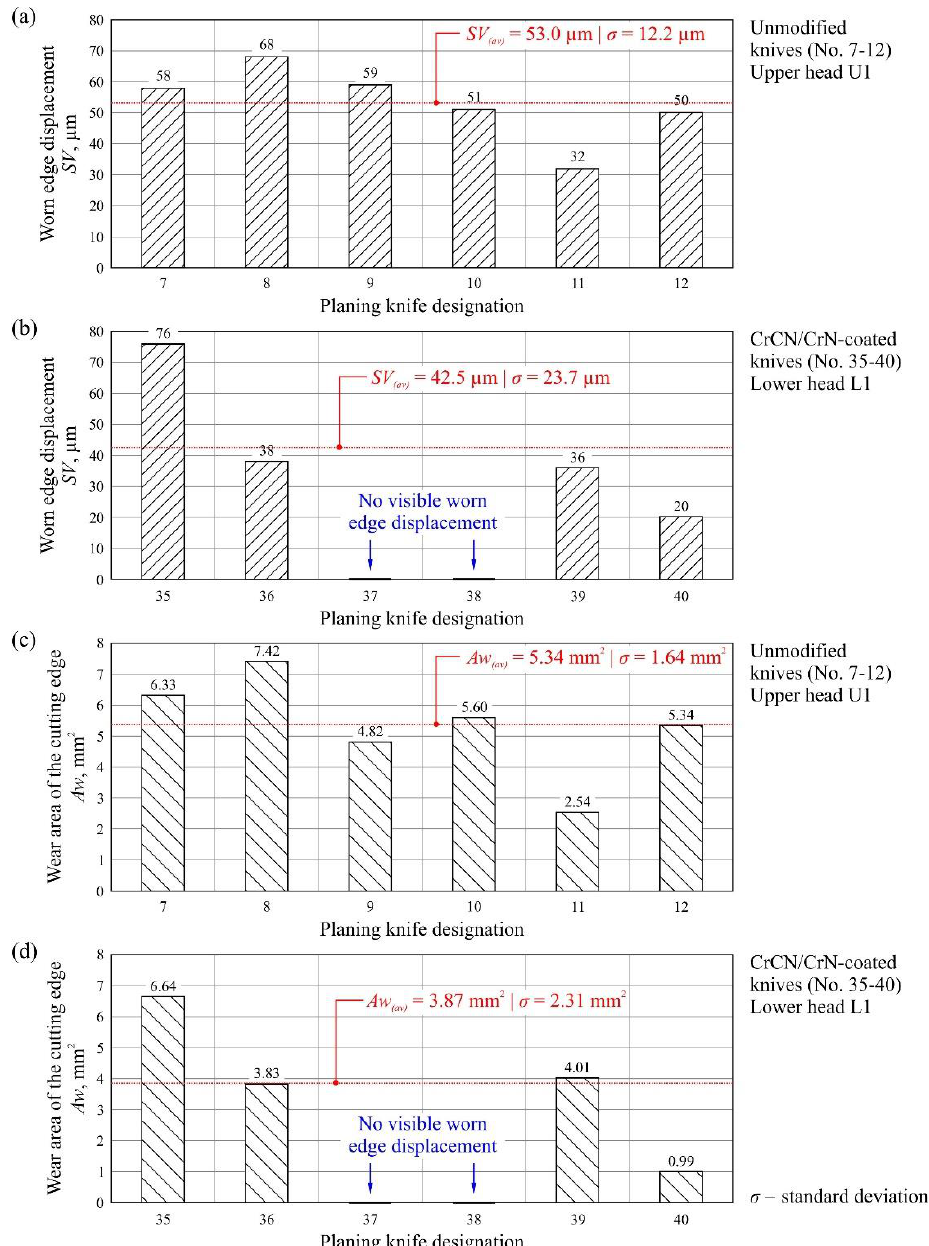
Figure 8. Measurement of the worn edge displacement ( SV ) of planer knives for ( a ) unmodified knives No. 7–12 and ( b ) CrCN / CrN-coated knives No. 35–40. Examples of specific values of wear area of the cutting edge for ( c ) unmodified knives No. 7–12 and ( d ) CrCN/CrN-coated knives No. 35 – 40.